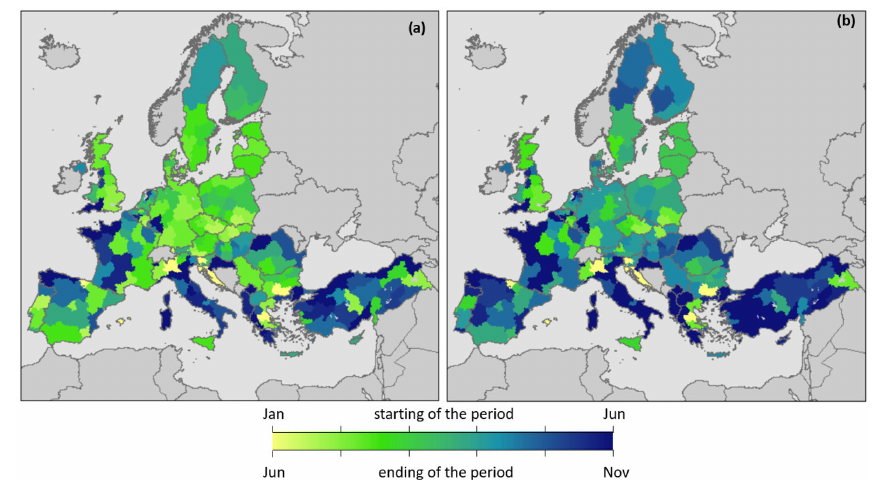
Figure 7. Spatial distribution of (a) the starting dekad and (b) the ending dekad of the local optimal period based on the average correlation and bounded by a length from 6 to 8 months.